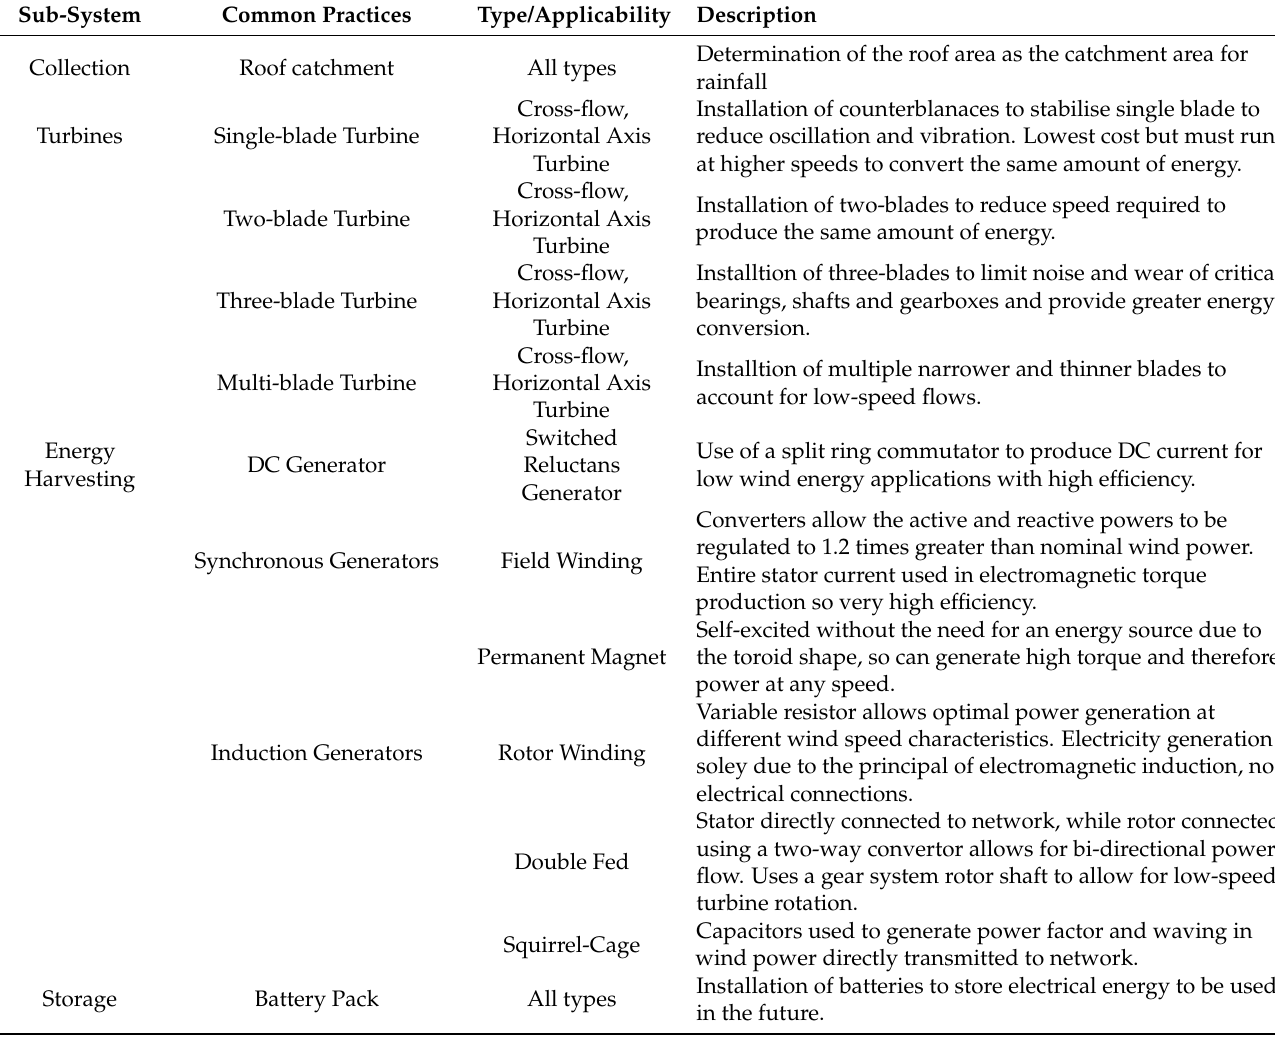
Table 2. Common types of rainwater energy-harvesting